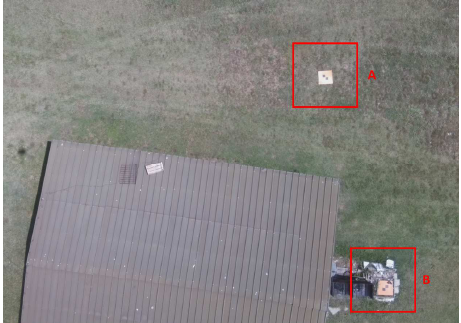
Figure 6. Marker placed on the ground (a) and on a structure in elevation (b).